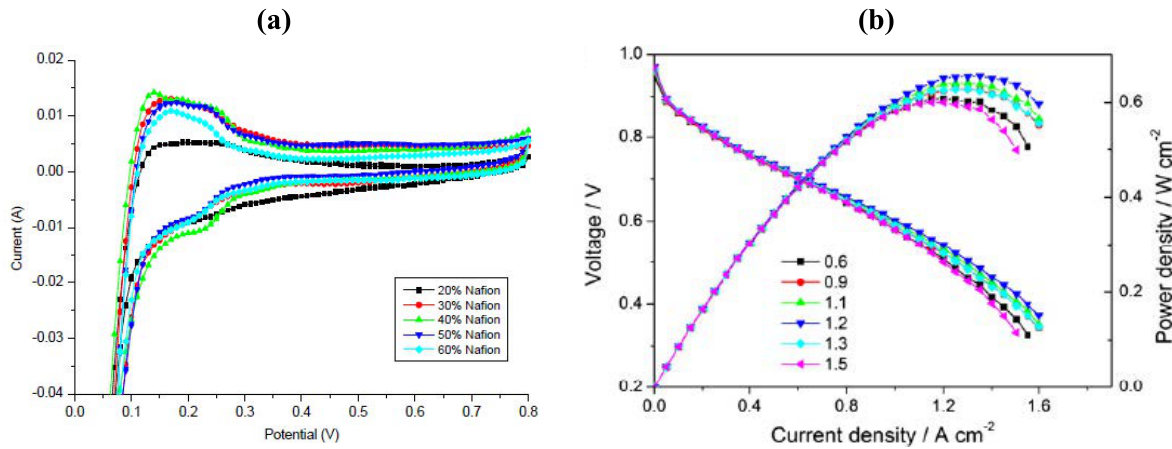
Figure 7. Influence of Nafion loading on ( a ) electrochemically active surface area (ESA) in the presence of nitrogen at 25 °C and 20 mV s − 1 and ( b ) fuel cell performance at 65 °C employing GDEs comprising carbon supported platinum catalyst. Reprinted with permission from [37,38]. Copyright 2012,